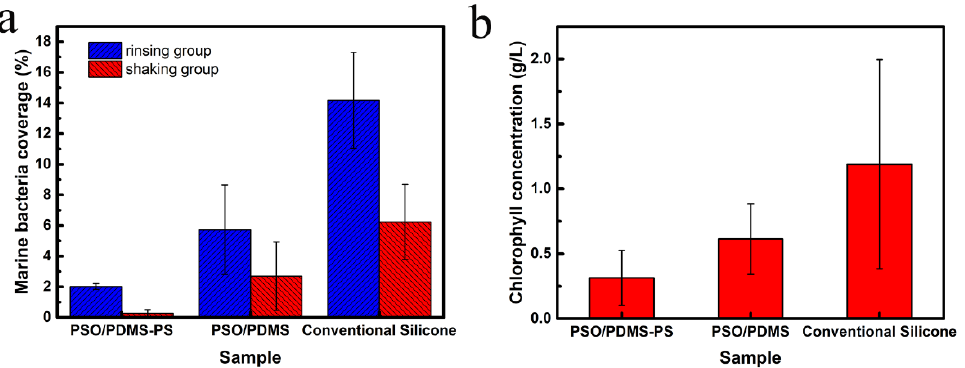
Figure 8. ( a ) Coverage of marine bacteria on the surface of the samples. ( b ) Chlorophyll concentration on the surface of the samples.